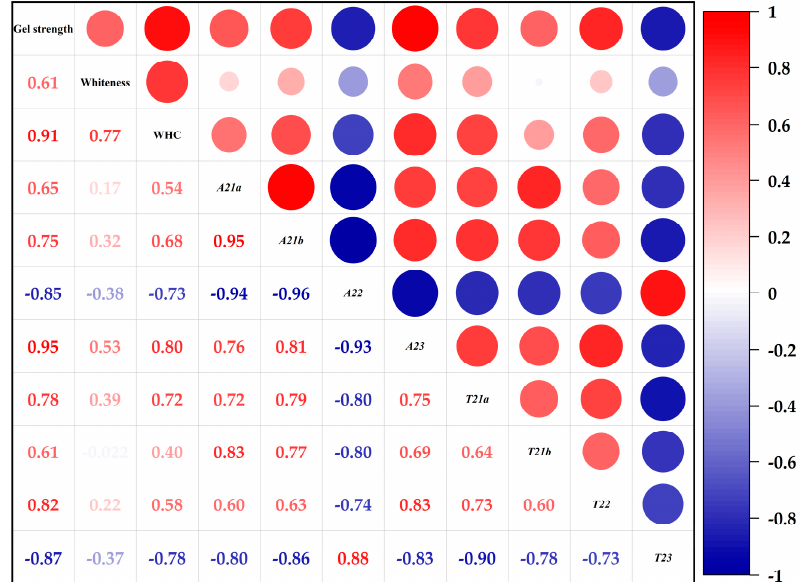
Figure 8. Correlation between water characteristics and gel strength during DPCD-induced gel formation in surimi (WHC: water-holding capacity, A 2b1 , A 2b2 , A 21 , and A 22 represent the contents of strongly bound water, weakly bound water, immobilised water, and free water, respectively, T 21 a , T 21 b , T 22 and T 23 represent strongly bound water, weakly bound water, immobilised water, and free water, respectively).